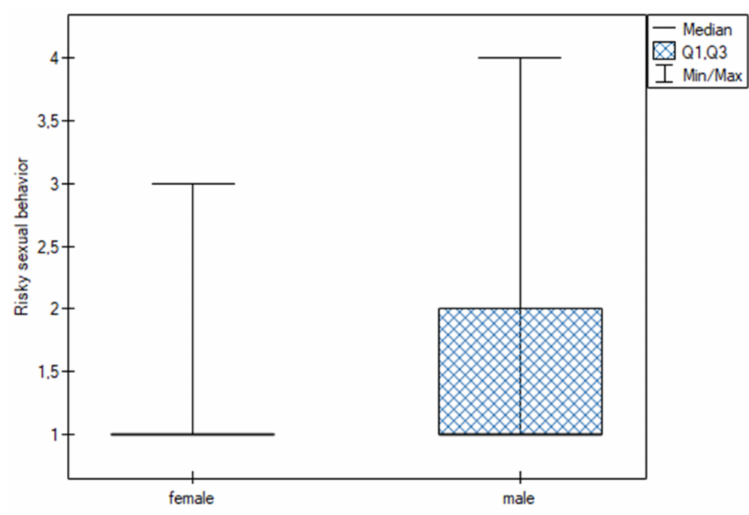
Figure 5. Risky sexual